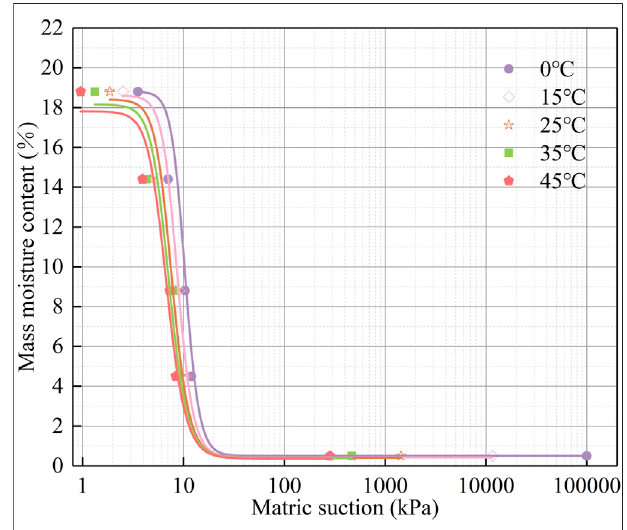
FIGURE 7 | SWCC with different temperatures.